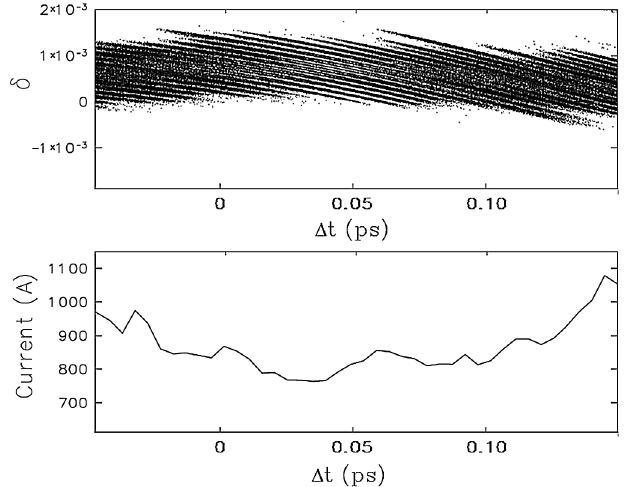
FIG. 8. Longitudinal phase space (top) and current profile (bottom) of the bunch core downstream of BC2 with R 56 ¼ (cid:2) 30 mm .